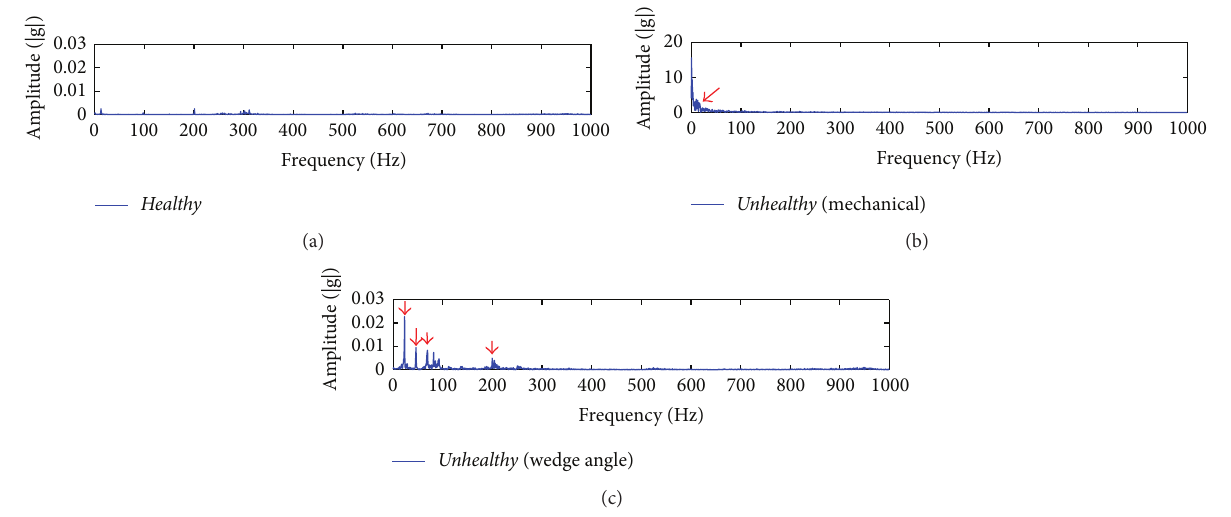
Figure 14: Vibration spectra of the “ healthy ” and “ unhealthy ” lapping processes.